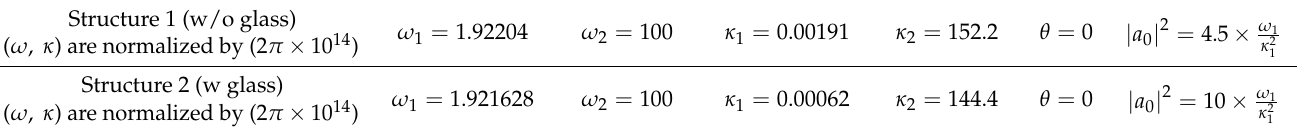
Table 3. Parameters of the Fano resonance in Figures 3, 6 and 7 (operating frequency = 0.9999 × 1.92162 × 10 14 × 2 π (rad/s)) *.